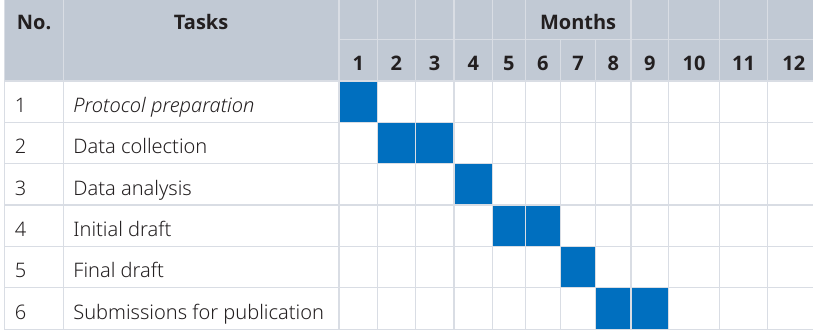
Table 1. Timeline chart of the research project